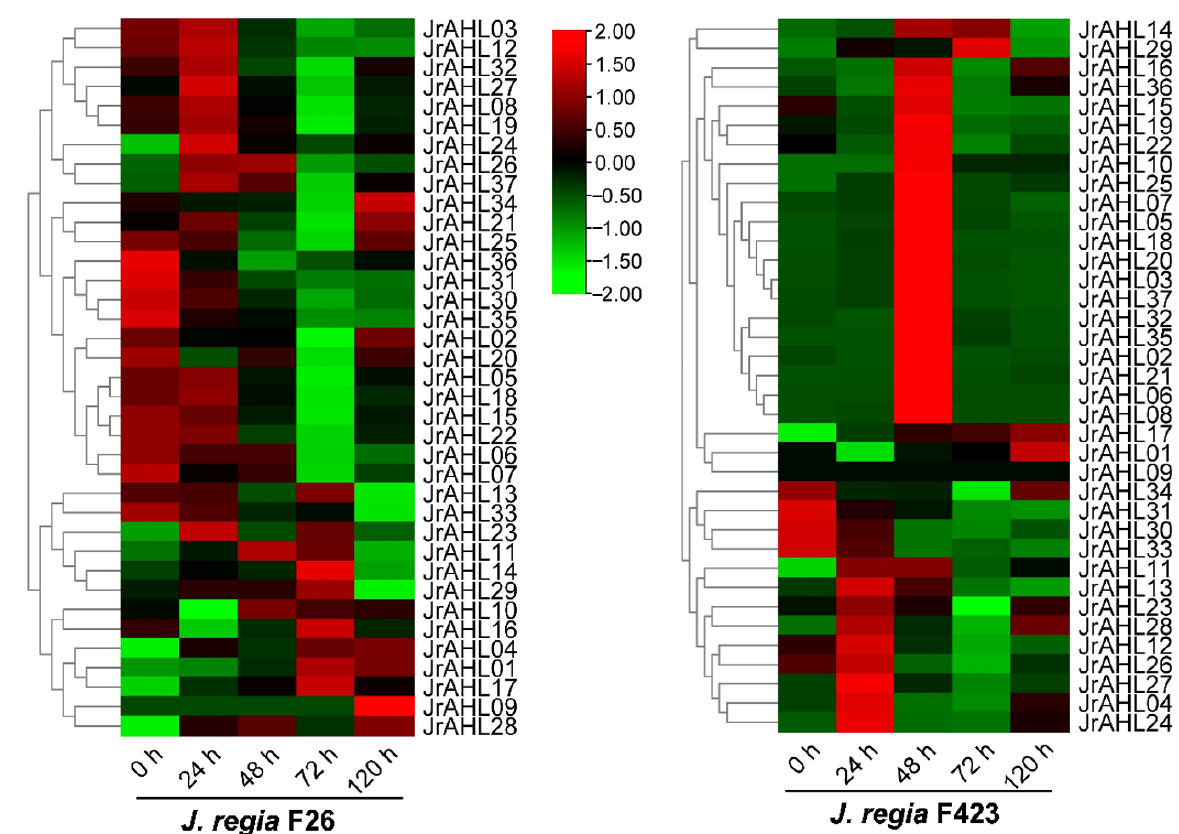
Figure 7. JrAHL gene expression profiles in F26 and the F423 fruits in response to anthracnose infection. The heat map was generated based on the transcriptomic data of the anthracnose-resistant F26 fruit bracts and anthracnose-susceptible F423 fruit bracts at five time points after infection with C. gloeosporioides .